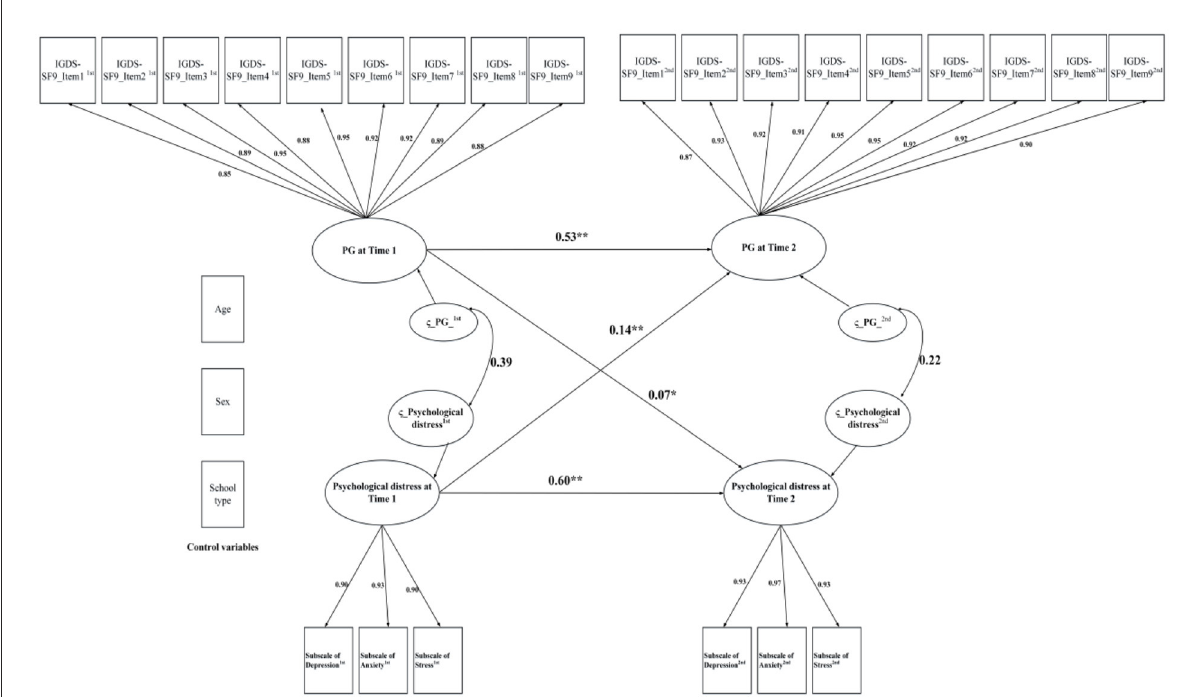
FIGURE4 Cross-lagged panel model of problematic gaming and psychological distress; PG, Problematic gaming; IGDS-SF9, Nine-item Internet Gaming Disorder Scale; * p < 0.05, ** p <